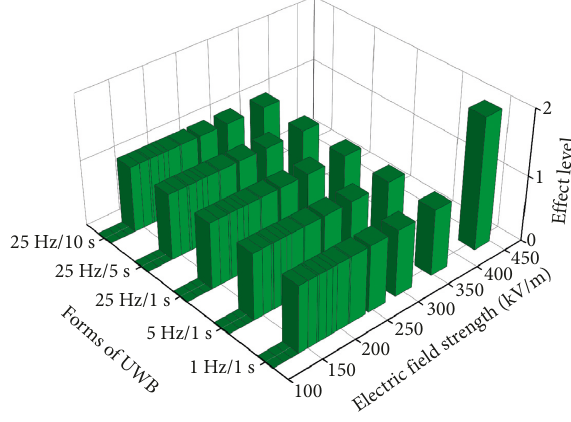
Figure 21: Test data of detector 1.